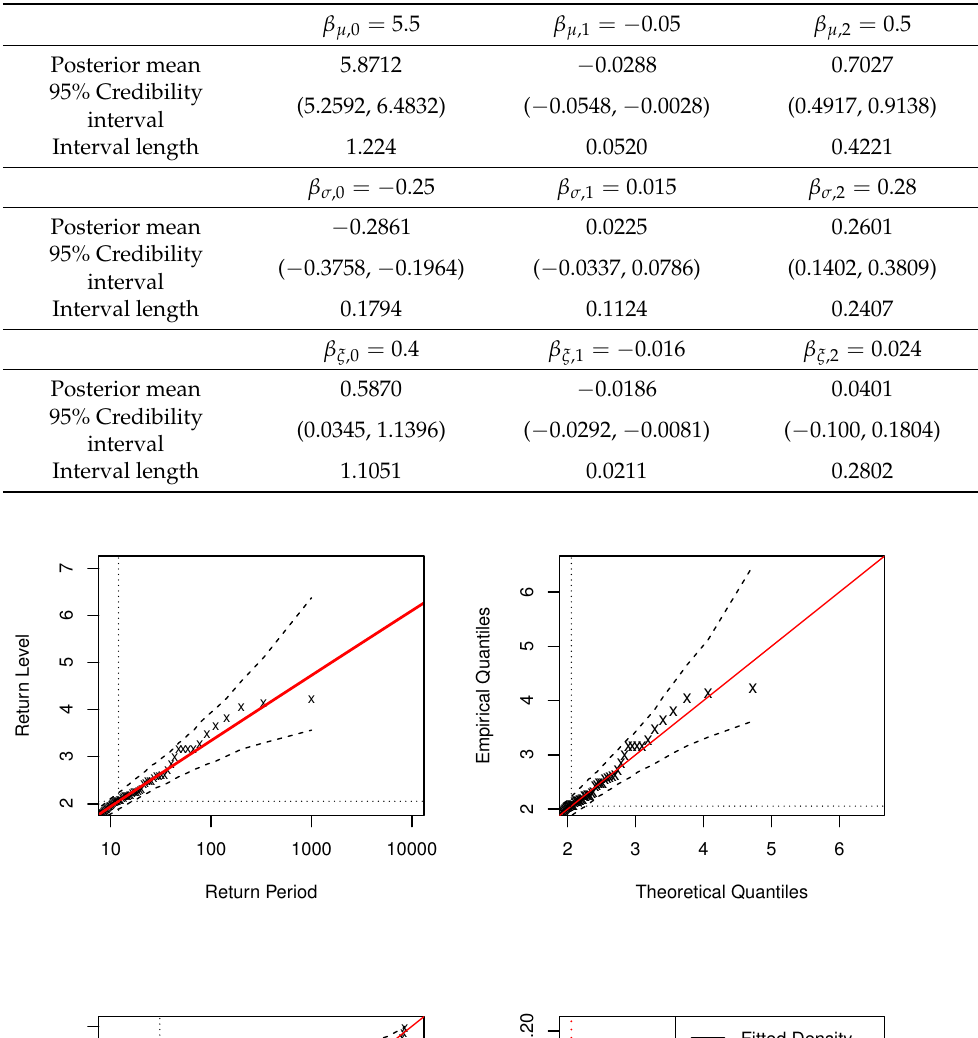
Table 1. Estimates for the regression coefficients of simulations with sample n = 500 .